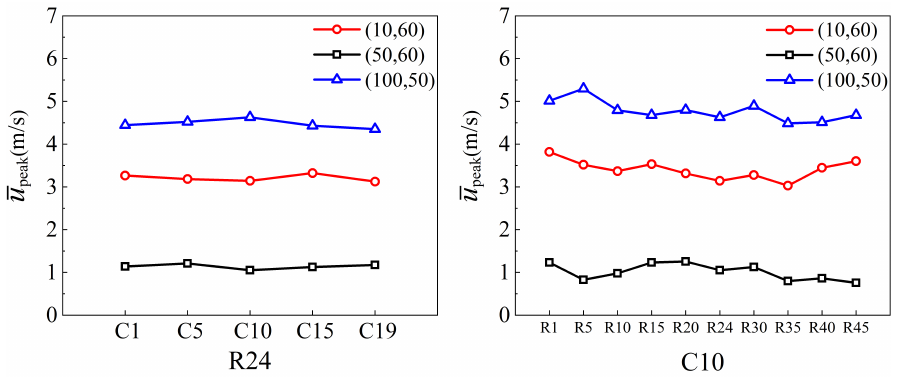
Figure 13. Synthetic jet uniformity along the orifices R24 and C10 at y o / d o =